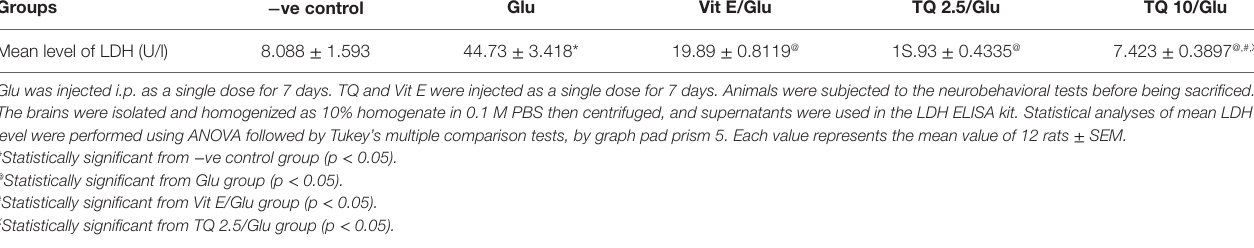
TaBle 6 | Effect of − ve control, Glu, Vit E/Glu, TQ 2.5/Glu, and TQ 10/Glu on lactate dehydrogenase (LDH) level. groups